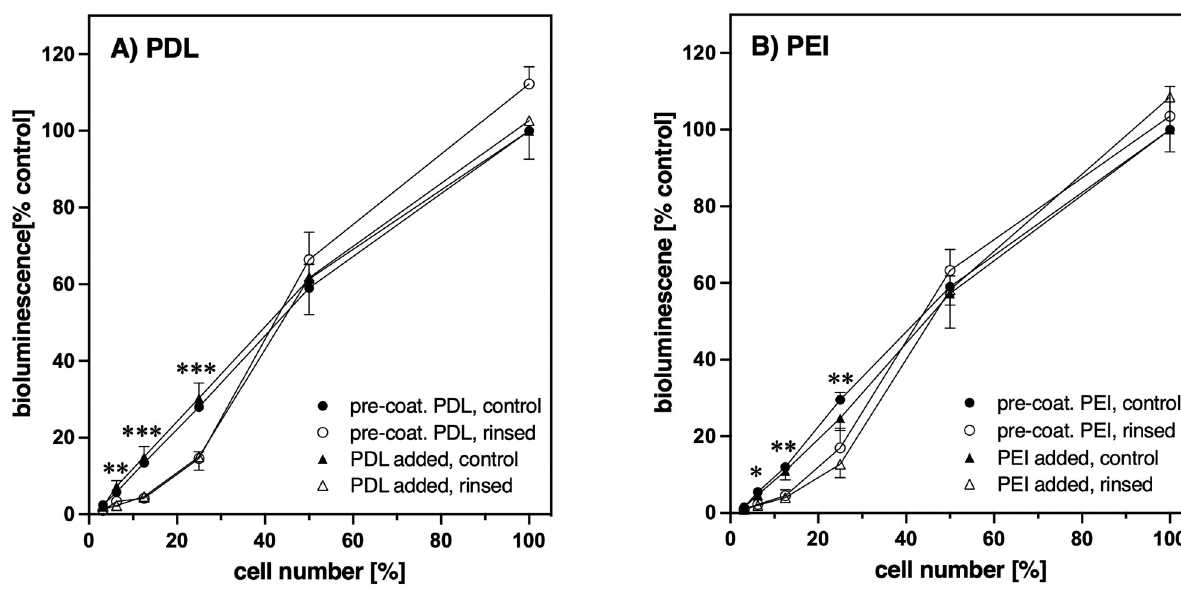
Fig 4. Effect of pre-coating or of direct addition of PDL and PEI on cell adherence with increasing cell density. Wells of a 96-well plate were either pre-coated ( ● , � ) with standard solutions of A) PDL (100 μ g/ml) or B) PEI (10 μ g/ml) followed by seeding of B 2 R R128A-RlucII expressing HEK 293 cells without addition, or the cells were seeded without pre-coating but with addition ( ▲ , Δ ) of A) PDL (2 μ g/ml) or PEI (1.5 μ g/ml). Cells were serially diluted two-fold starting with approx. 30.000 cells per well. After 2–3 d adherence was determined as described in legend of Fig 2. The wells with the highest cell density were confluent and taken as 100%. Symbols represent Mean ± SEM (n = 4–5, performed in duplicates). Rinsed ( ● , ▲ ), control ( � , Δ ). Multiple unpaired t-test with Welch correction and Holm-Sidak’s multiple comparison test for all values (pre-coated and addition together) of rinsed vs. control cells for each dilution: � p < 0.05, �� p < 0.01, ��� p <